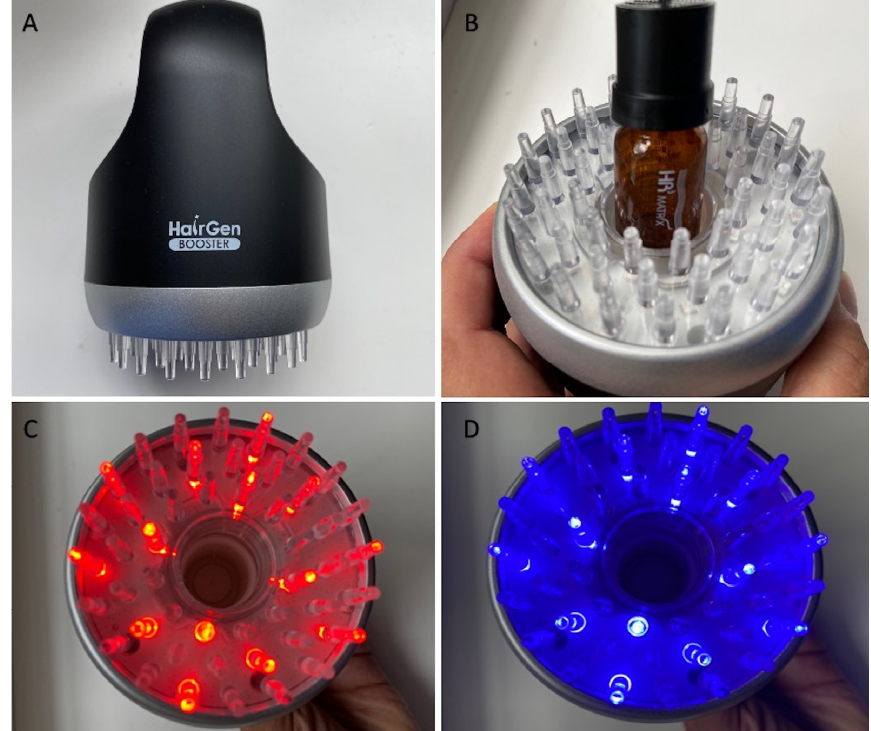
Figure 1. MND and LLLT protocol ( A ) Hairgen Booster ® (DTS MG Co., Ltd., Seoul, Korea, #B108-